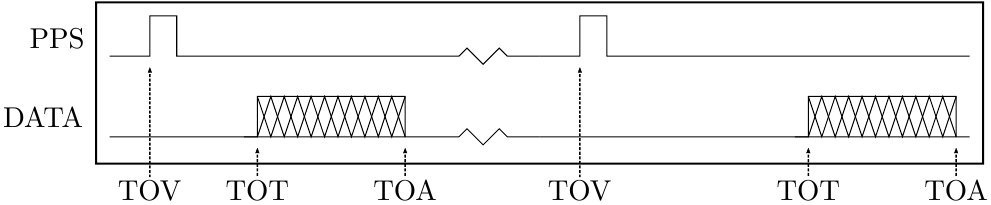
Figure 3. Visualization of the time-of-validity (TOV), time-of-transport (TOT) and time-of-arrival (TOA). The PPS signal line produces a rising edge when the measurement is valid, and the data is transferred after a delay. Note this delay between TOV and TOT may vary, for example due to internal calculation delays.